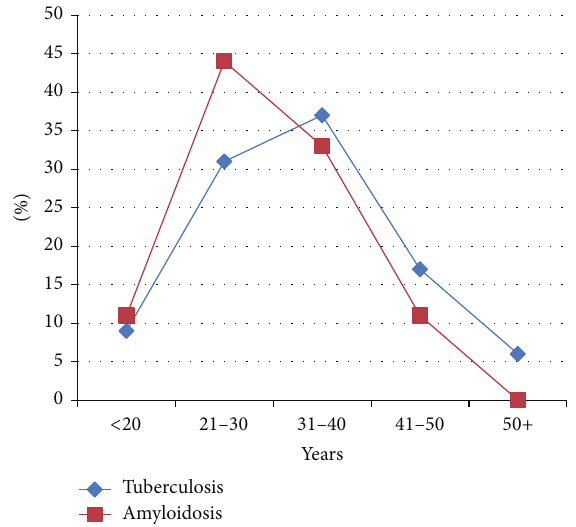
Figure 2: Description tuberculosis positive patients by age.